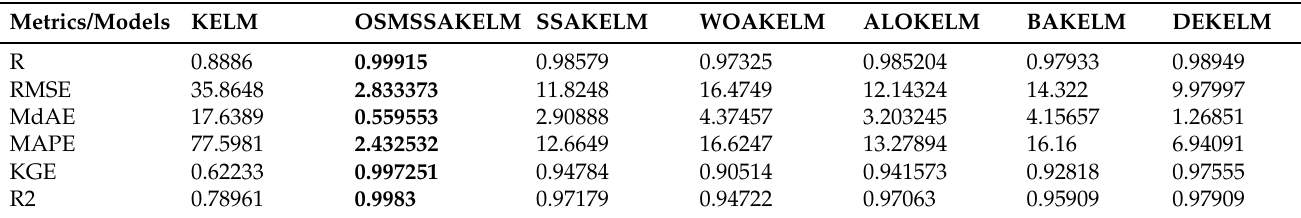
Table 3. Comparison of the average training results for different optimized KELM models.